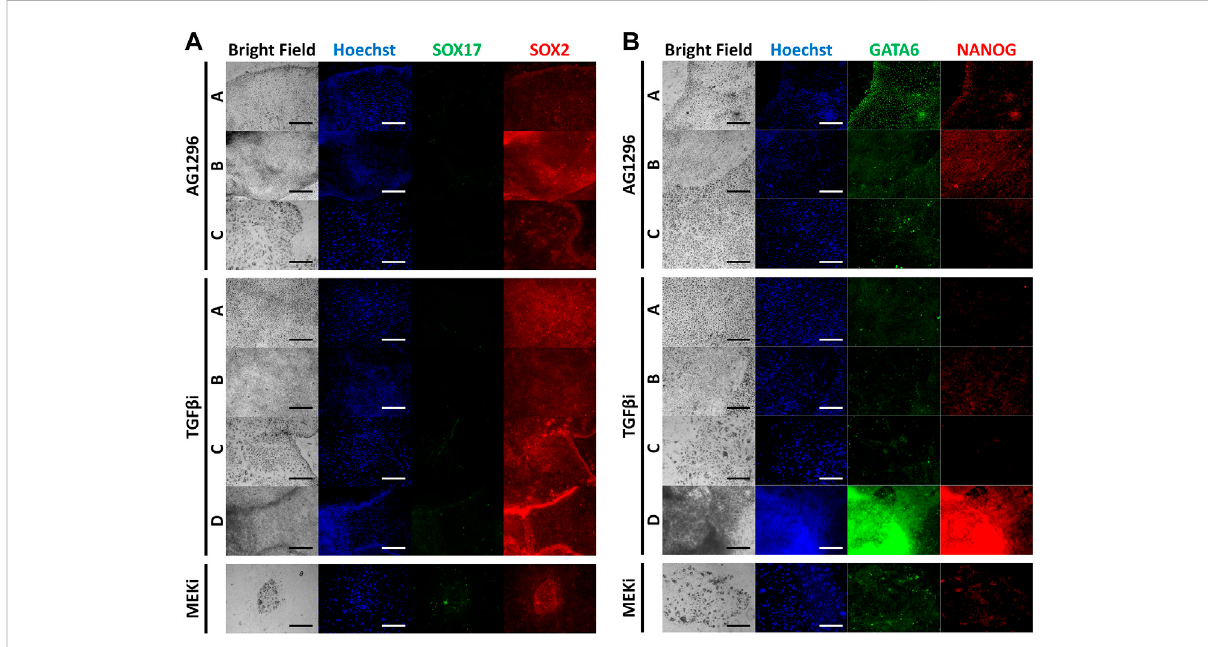
FIGURE 5 Immunocytochemistry images of inhibitor-treated cell types for marker proteins. (A) Immunocytochemistry staining of SOX17 and SOX2 with inhibitor-treated cell types. (B) Immunocytochemistry staining of GATA6 and NANOG with inhibitor-treated cell types. (TGF β i, transforming growth factor β inhibitor; MEKi, mitogen-activated protein kinase inhibitor).